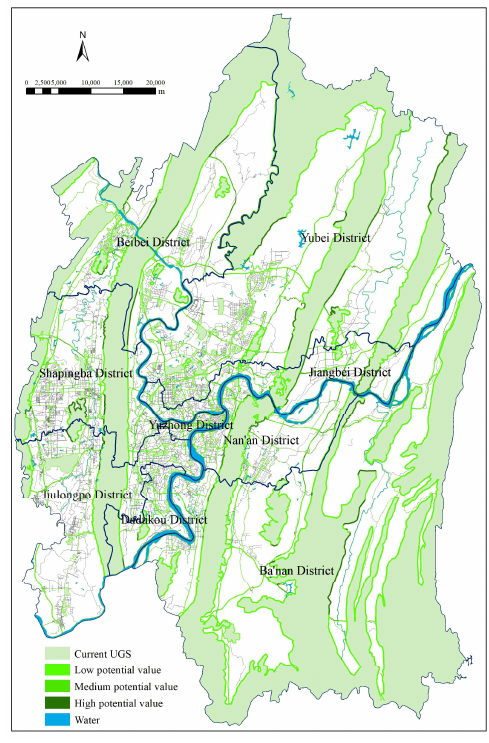
Figure 6. Comprehensive map of potential areas for UGS expansion.